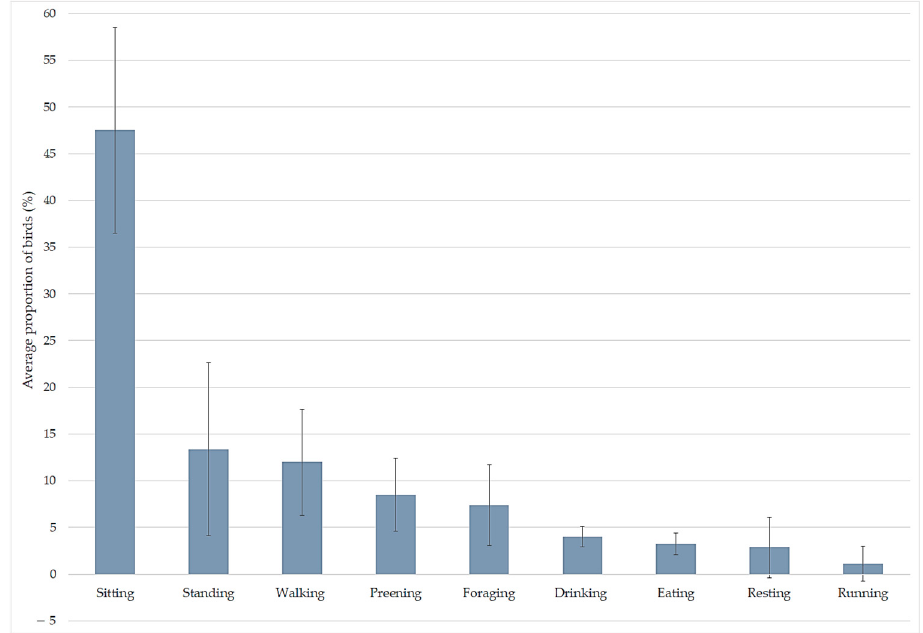
Figure 2. Average proportion of birds observed performing different state behaviours (mean ± SD) during behavioural observations (5 min per farm) on organic broiler farms ( n = 8 farms).